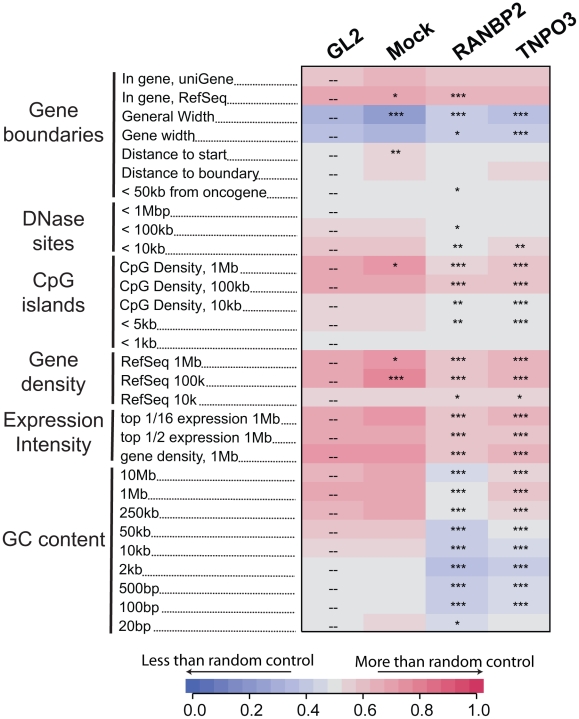
Effects of Transportin-3 and RanBP2 depletion on integration near multiple chromosomal features.Genes targeted by siRNA in infected cells including the control, GL2, are shown above the columns. Mock cells received no siRNA. The genomic features analyzed are shown in the rows and labeled on the left. Relationships between integration frequency and feature density are summarized using ROC curve areas [18], where increasing shades of blue indicate a negative correlation with integration frequency and increasing shades of red indicate a positive correlation with integration frequency relative to matched random control distributions. The control GL2 siRNA set was used for pairwise statistical comparisons (overlay dashes). P values summarizing the significance of the departure from the GL2 control are shown with asterisks (*P<0.05; **P<0.01; ***P<0.001). Note that the asterisks and the heat map summarize different comparisons (to siGL2 and matched random controls, respectively). The base pair values in the row labels indicate the size of the genomic interval used for analysis–often the most appropriate interval is not known, so several different interval sizes are compared. A more detailed guide to the data presented in this figure can be found in Text S1. An interactive version of this figure is available as Figure S5.